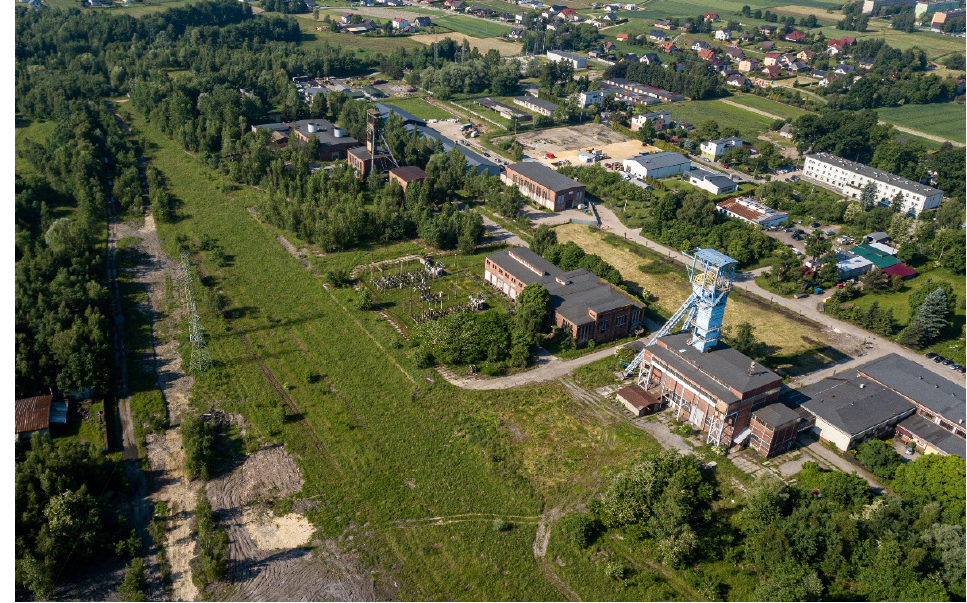
Figure 6. Inactive Hard Coal Mine Brzeszcze East, June 2021 (M. Kramarczyk).